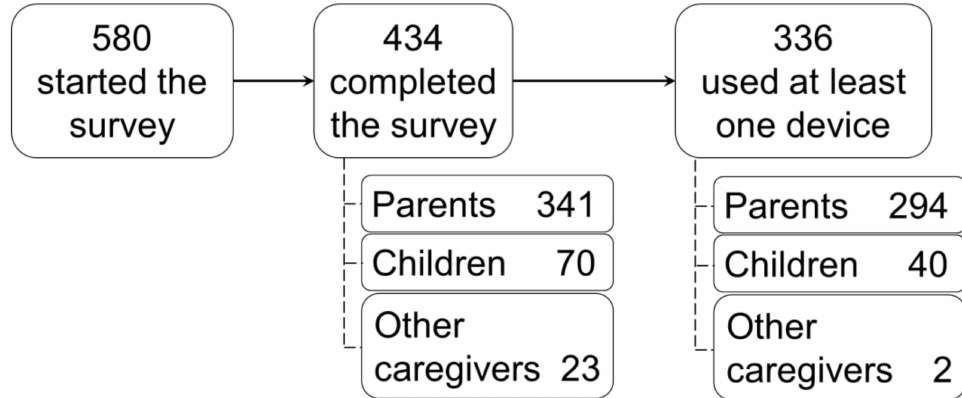
Figure 1. Flow chart of data